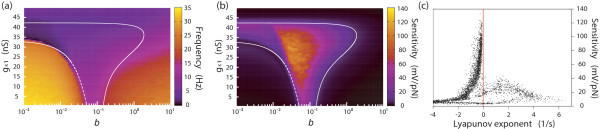
Maximal sensitivity of the noisy hair cell. Throughout the
b-gK1-parameter plane, we determined
the sensitivity of the stochastic model as a function of frequency. This
was done using Equation 7 and a Gaussian external force that was
band-limited to 200 Hz and had a standard deviation of 1 pN. For each
choice of the parameters, we determined at which frequency the
sensitivity was maximal. (a) Frequency map of the maximal
sensitivity. As a color plot, we show the frequencies at which the
sensitivity of the cell is maximal within the frequency band of the
stimulus. (b) Maximum sensitivity map. Color coded, we plot the
maximal sensitivity as a function of the bifurcation parameters b
and gK1. In (a, b),
bifurcation lines of the AH bifurcation of the deterministic system are
shown as white lines. (c) Scatter plot of the maximal sensitivity
versus the LE of the model, both taken at the same values of the control
parameters b and gK1. Note that the LE was
determined in the absence of any external stimulus force but in the
presence of noise. The vertical red line indicates where the LE is
zero.